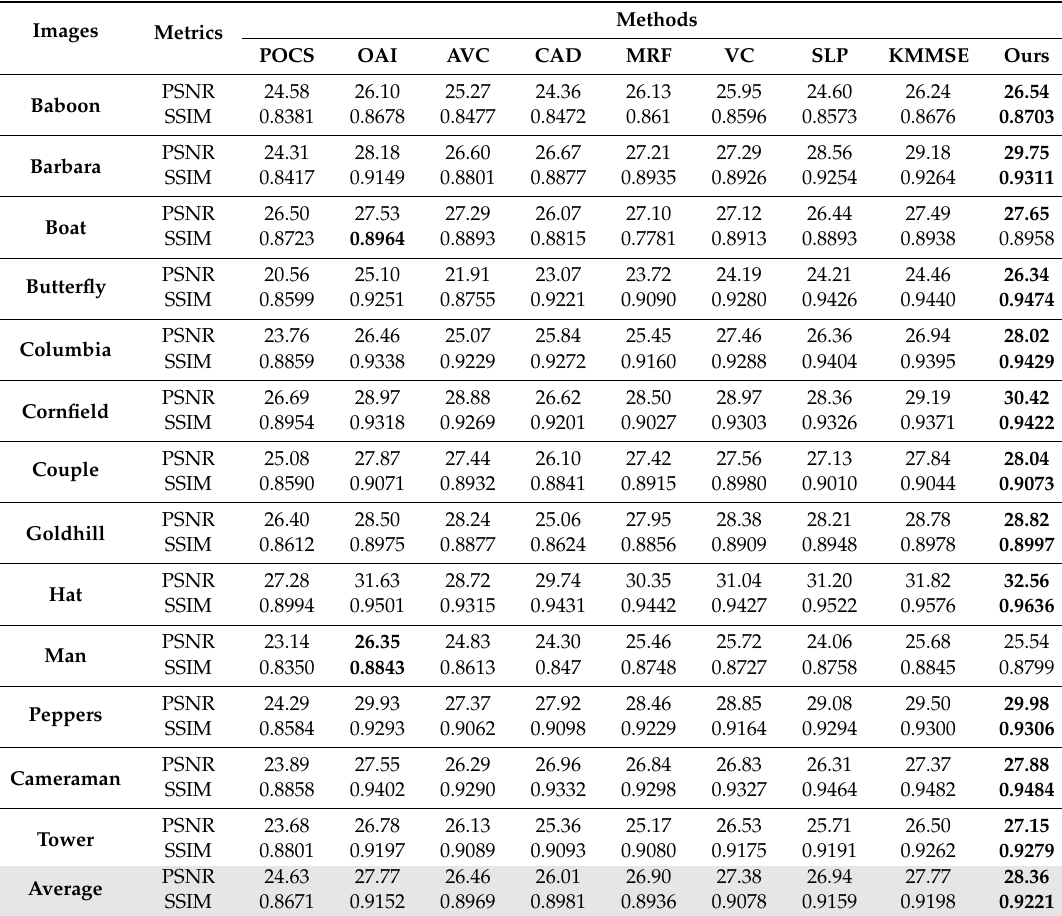
Table 2. Peak signal-to-noise ratio (PSNR) and structural similarity (SSIM) index in comparison to EC algorithms with 16 × 16 regular isolate block